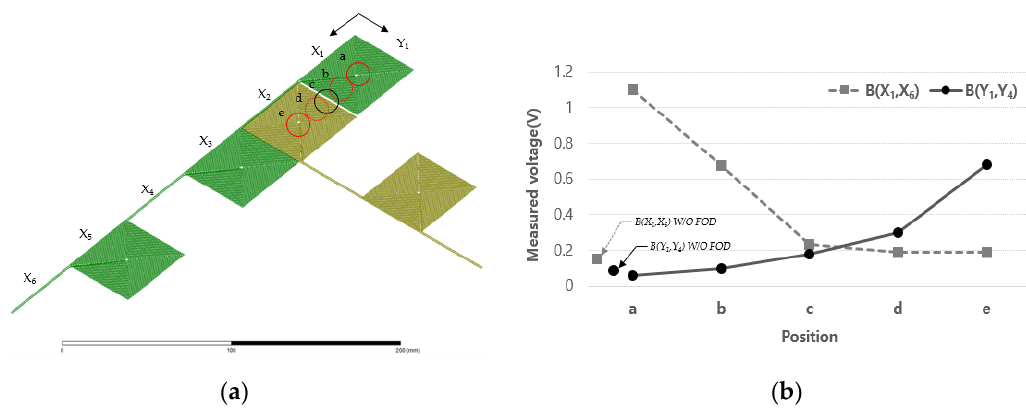
Figure 14. V AB according to MO’s position ( a ) MO position in a balanced coil, ( b ) measured V AB . Table 3. V AB according to MO’s position.